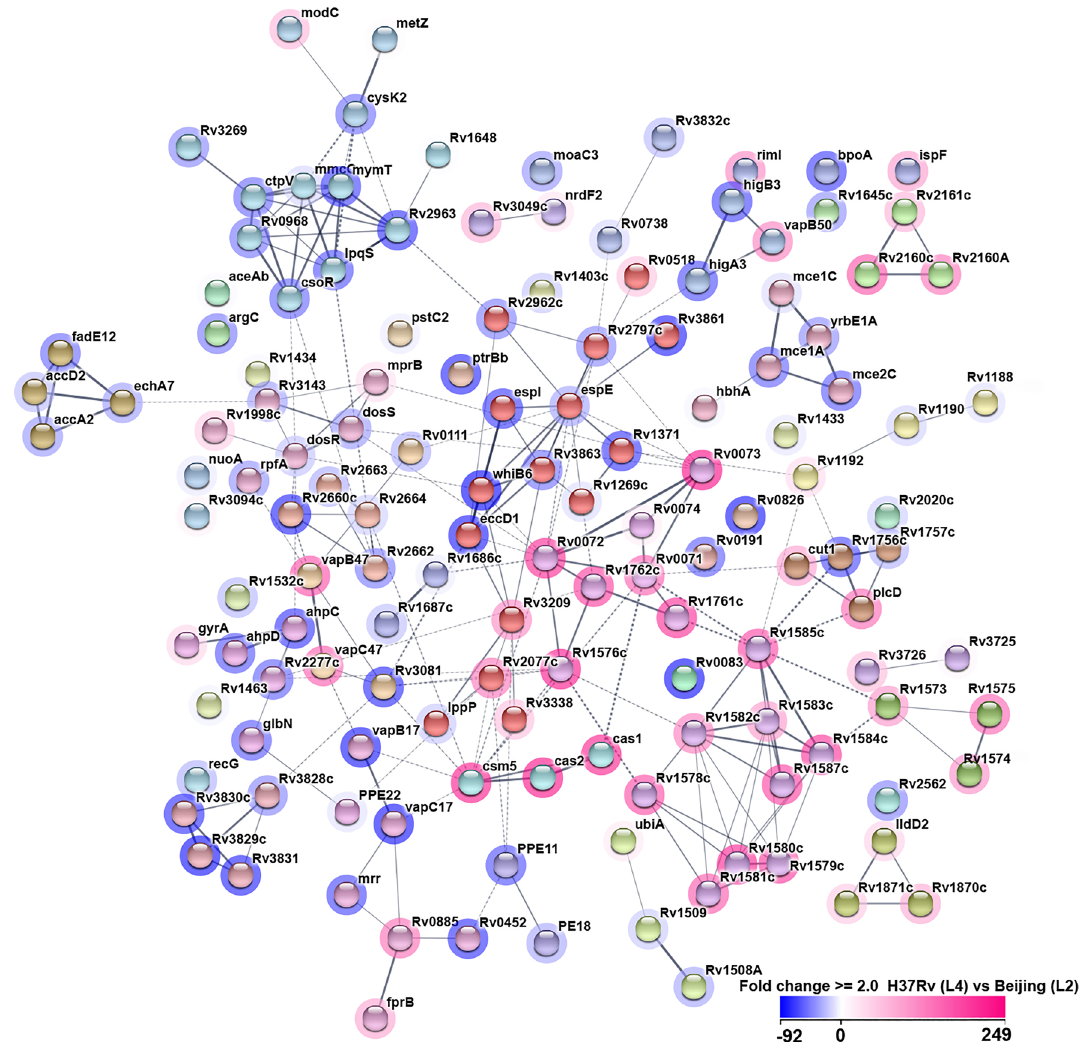
Figure 8. STRING association network of differentially expressed genes. Functional association and interactions for the 139 ≥ two-fold differentially expressed genes at day 10 between H37Rv (L4) and Beijing (L2) (three independent experiments per condition). Links between genes show their joint contribution to specific biological functions and the degree of confidence prediction is represented by the thickness of the line. Lines are either dashed or solid if genes are found to be clustered by the cluster algorithm MCL run on the distance matrix obtained from the STRING global scores. Nodes are colored by clusters and every color represents a different cluster. Halos around nodes show the degree of up- or down-regulation in shades of blue and pink, respectively, in H37Rv (L4) compared to Beijing